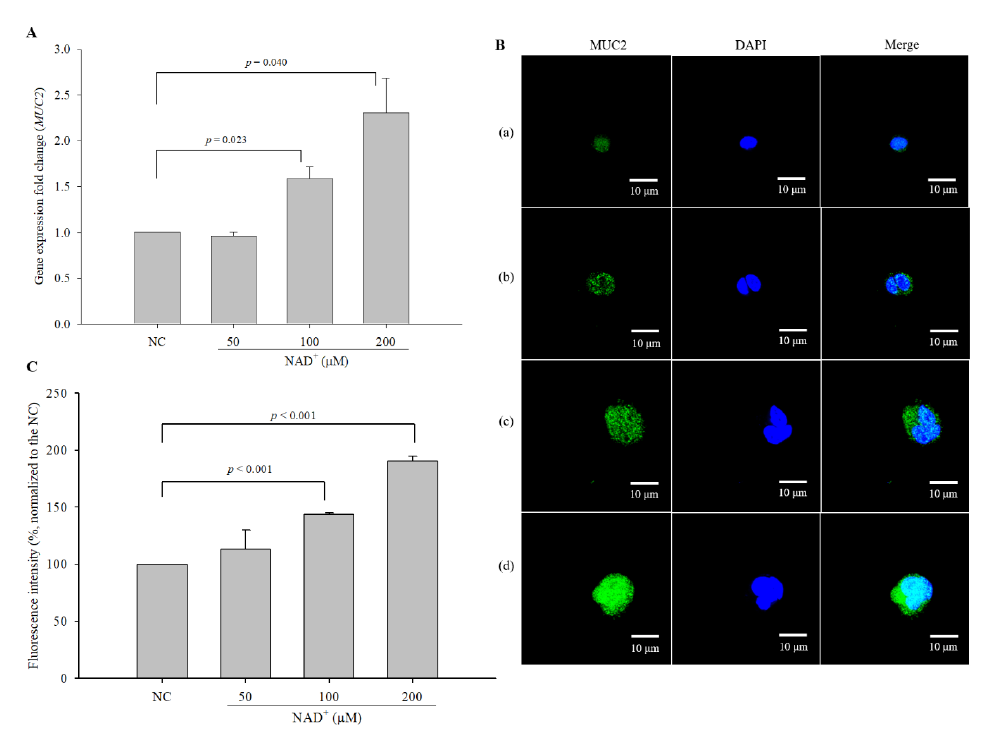
( a ) Negative control, ( b ) 50 µ M NAD + , ( c ) 100 µ M NAD + , ( d ) 200 µ M NAD + . The data are expressed